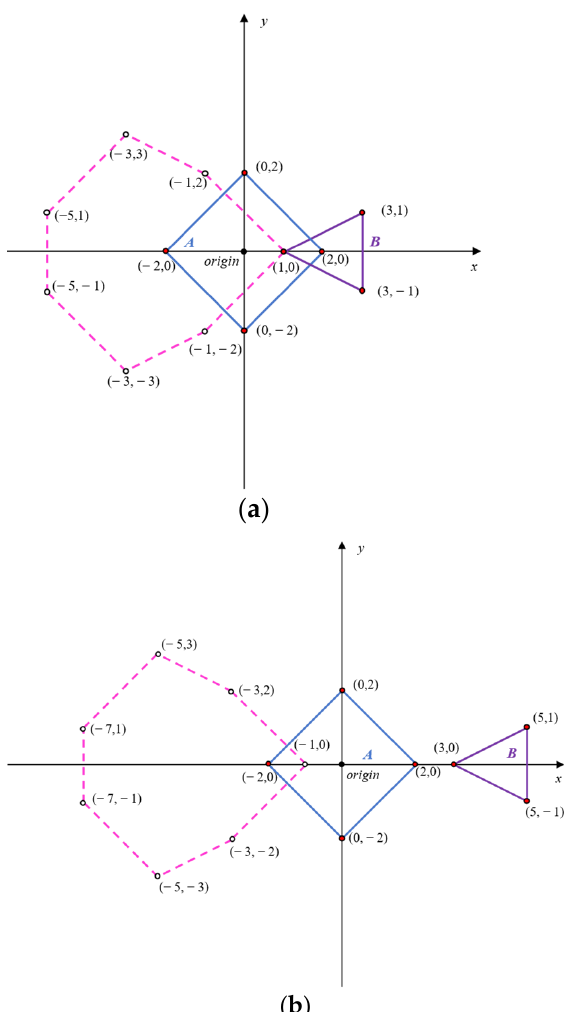
Figure 6. Examples of using Minkowski differences to determine convex shapes collision: ( a ) example of intersecting shapes; ( b ) example of nonintersecting shapes.